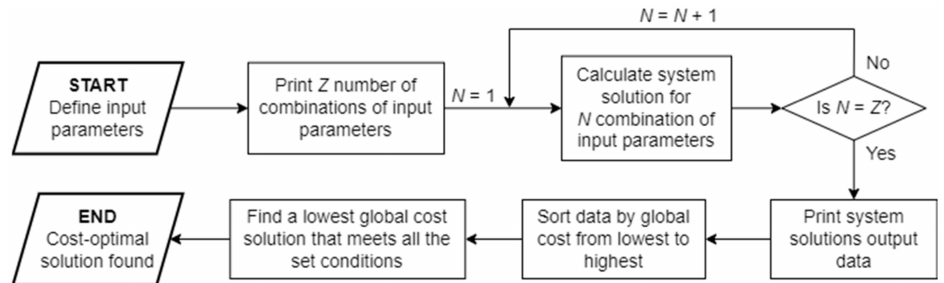
Figure 8. Scheme of the optimization